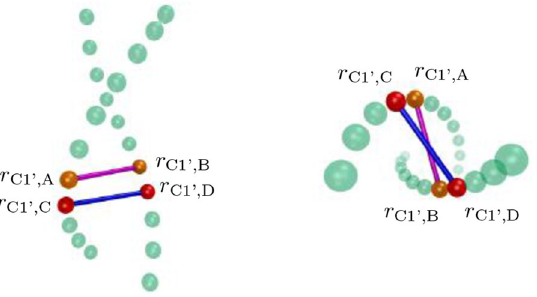
Figure 5. Left: Side perspective of backbone atoms along a helical fragment of DNA. Beads r represent C1’ atoms along the DNA backbone. Right: Top view of backbone atoms along the helical